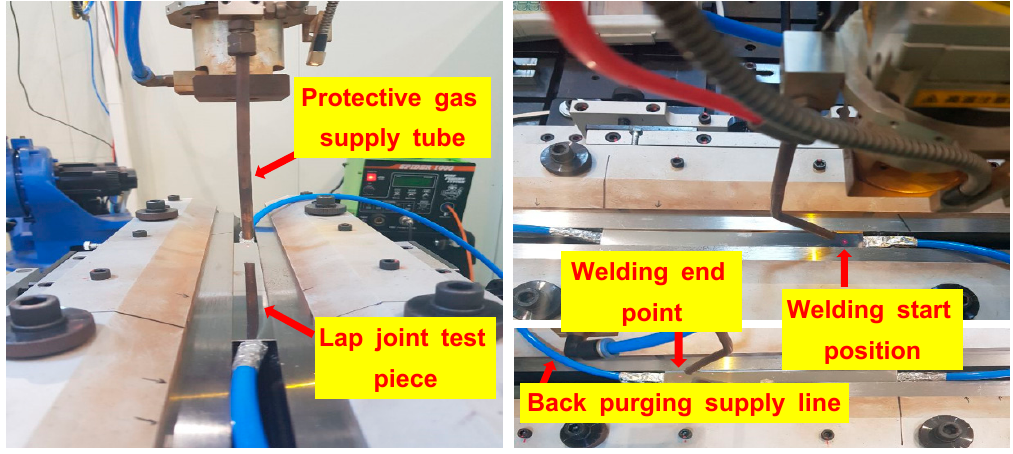
Figure 3. Lap joint welding jig setting.